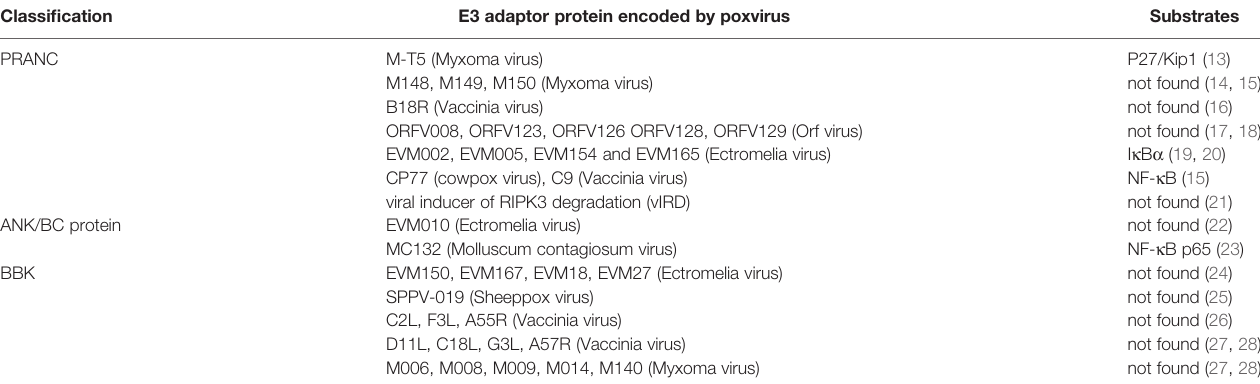
TABLE 2 | Summary of poxvirus adaptor proteins for E3 ubiquitin